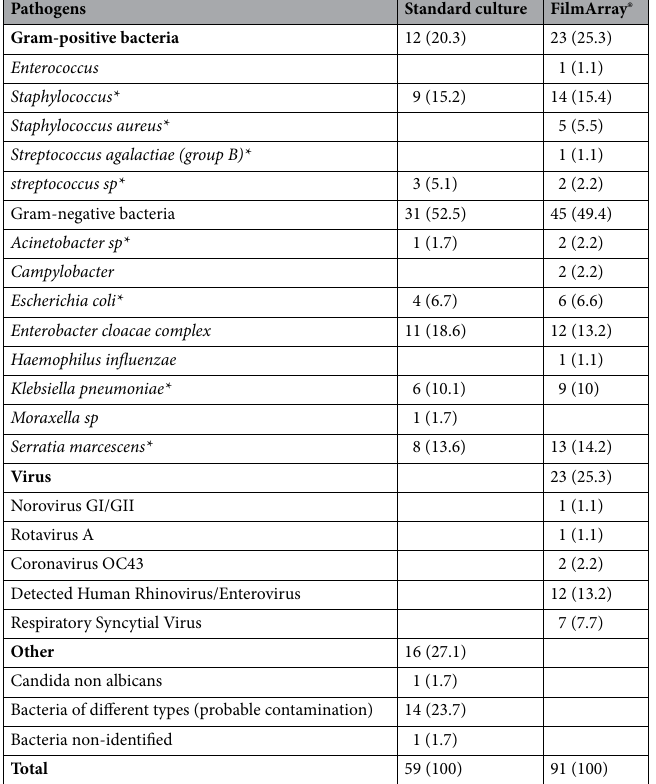
Table 2. Microbiology investigation results. Data are shown as number (%) of patients. * Pathogens found in